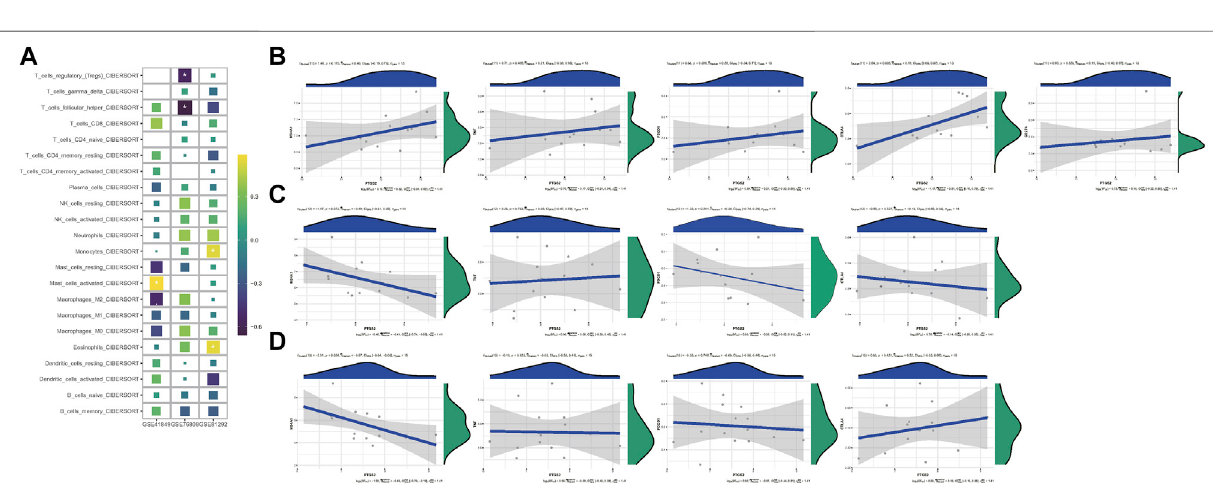
FIGURE3|(A) HeatmapdepictingtherelationshipbetweentheCIBERSORTscoresof22immunecellsandthePTGS2expressioninGSE48149,GSE76808,and GSE81292 datasets. p -values were showed as: ns, not signi fi cant;**, p < 0.05; **, p < 0.01; ***, p < 0.001. (B) Spearman correlation ofPTGS2 expression level with the expression ofMS4A1(CD20),TNF(TNF α ),PDCD1, CTLA4,andCD274(PD-L1)inGSE48149. (C) Spearmancorrelation ofPTGS2 expression levelwiththeexpression ofMS4A1(CD20),TNF(TNF α ),PDCD1,andCTLA4inGSE76808. (D) SpearmancorrelationofPTGS2expressionlevelwiththeexpressionofMS4A1(CD20),TNF (TNF α ), PDCD1, and CTLA4 in